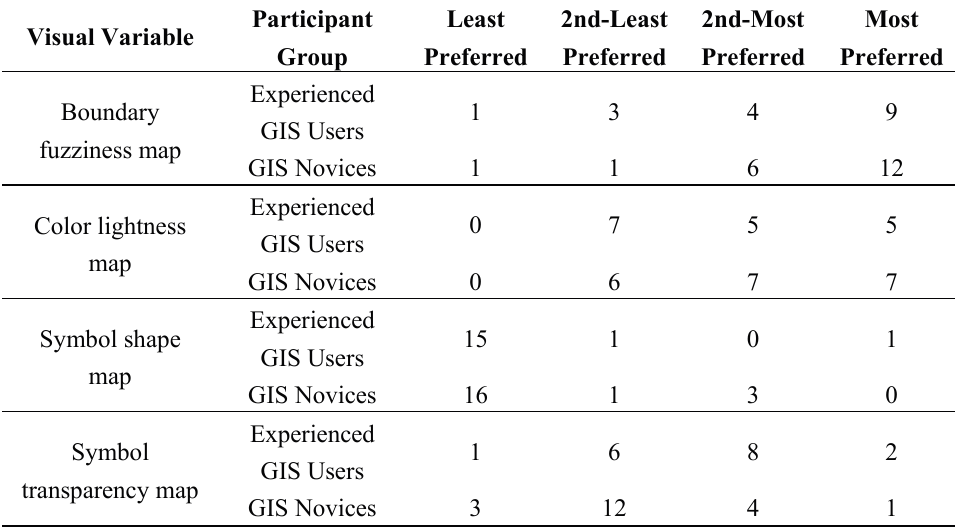
Table 1. Number of preference ranking for the four